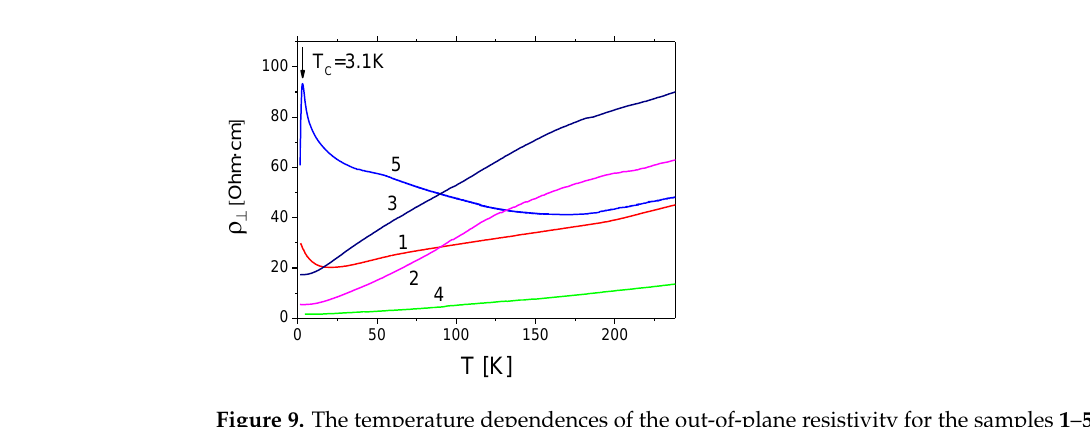
Figure 9. The temperature dependences of the out-of-plane resistivity for the samples 1 – 5 : 2-FPy ( 1 ); 2,3-DFPy ( 2 ); 2-Cl-3-FPy ( 3 ); 2,6-DClPy ( 4 ); 2,6-DFPy ( 5 ).